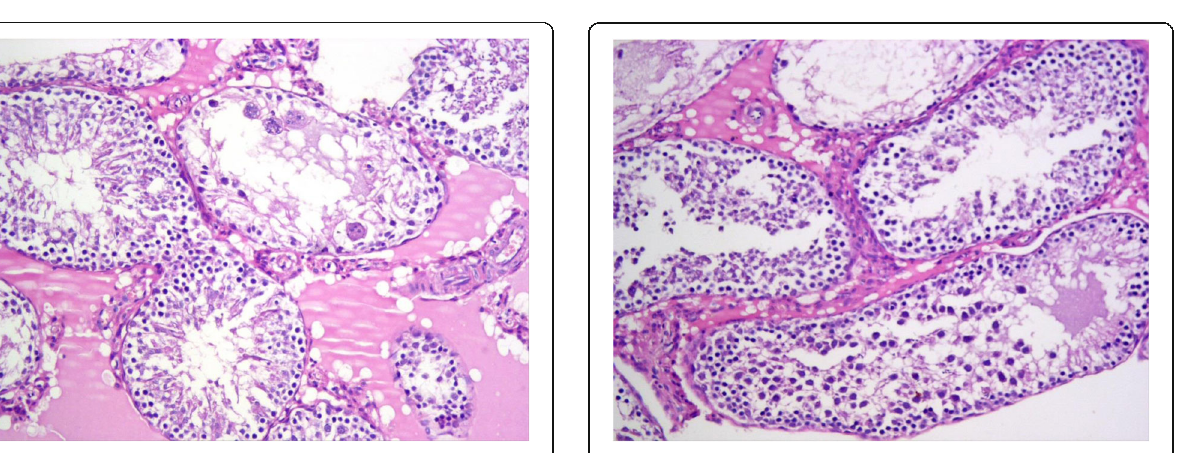
Fig. 6 Testicular section from the tramadol group showing disorganized spermatogenesis, vacuolar degeneration, interstitial oedema and reduced number of Leydig cells (H & E, ×